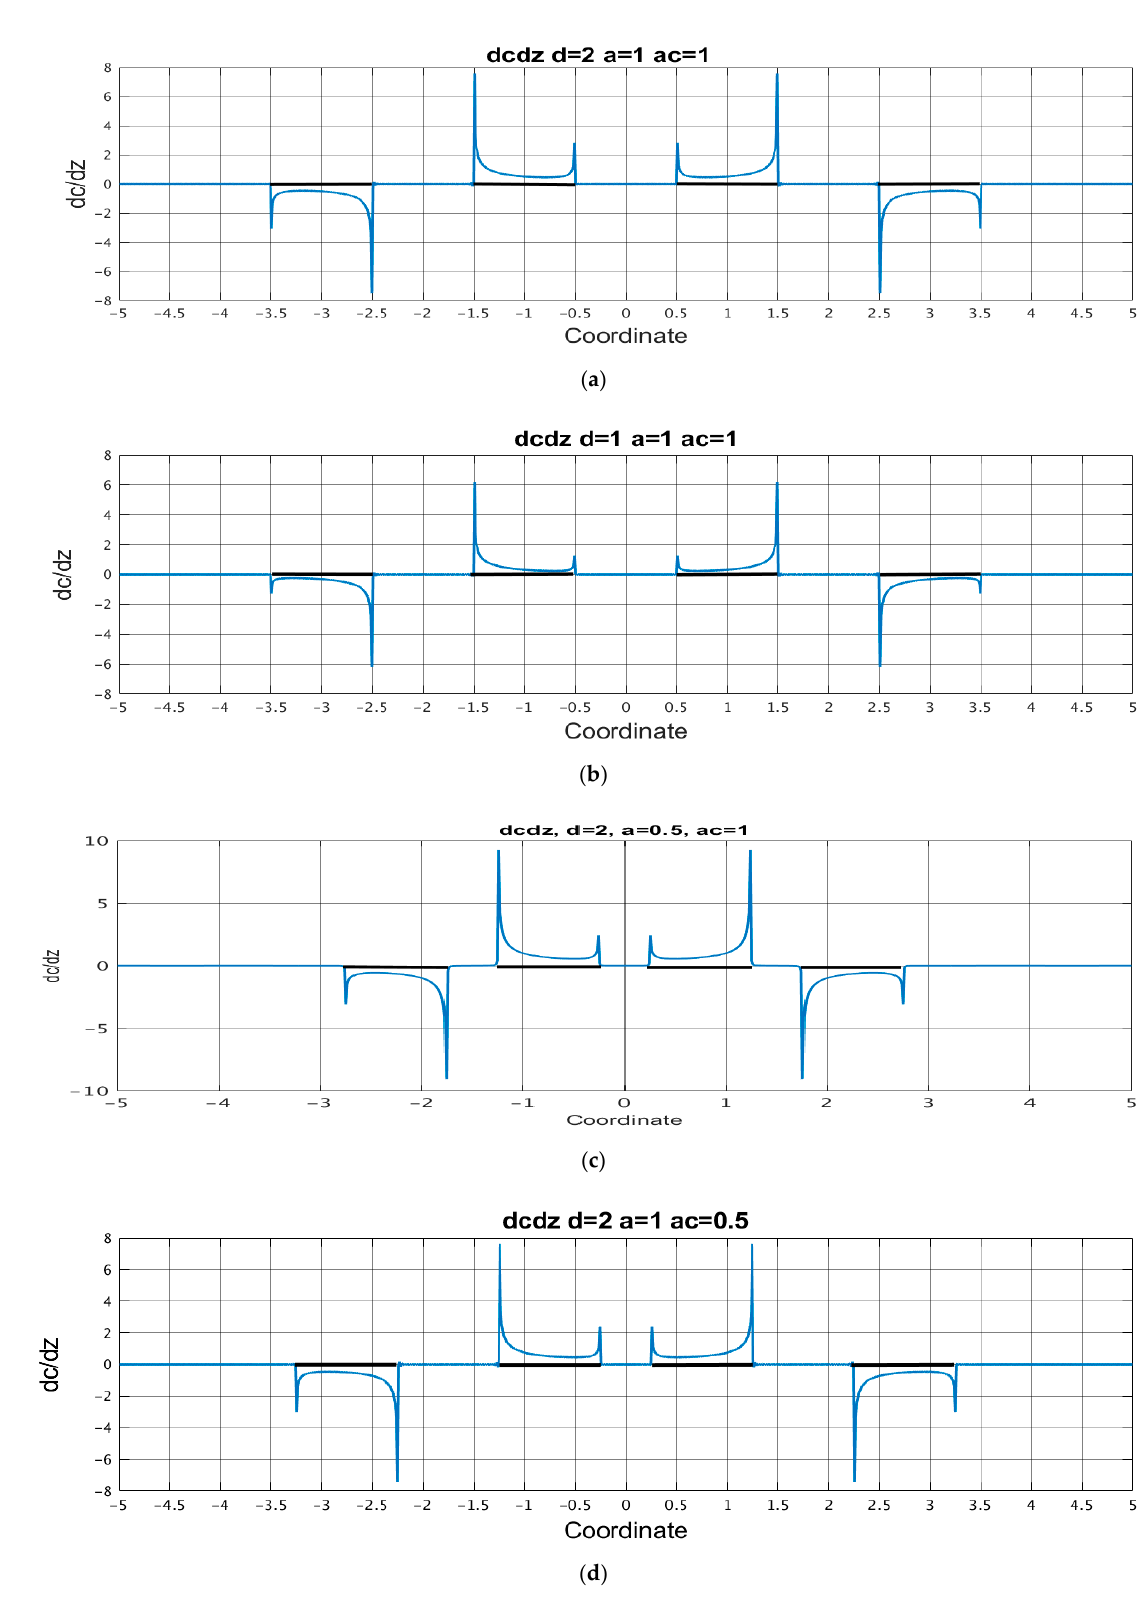
Figure 7. Normal component of the stationary concentration gradient distribution. ( a ) (cid:101) d = 2; (cid:101) a = 1; (cid:101) a c = 1; ( b ) (cid:101) d = 1; (cid:101) a = 1; (cid:101) a c = 1; ( c ) (cid:101) d = 2; (cid:101) a = 0.5; (cid:101) a c = 1; ( d ) (cid:101) d = 2; (cid:101) a = 1; (cid:101) a c = 0.5. The black thick lines show the areas on the channel wall where the electrodes are located.